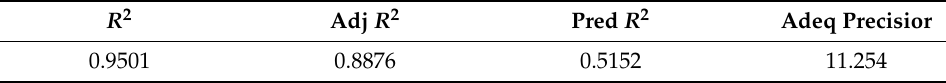
Table 5. ANOVA results of delamination factor.